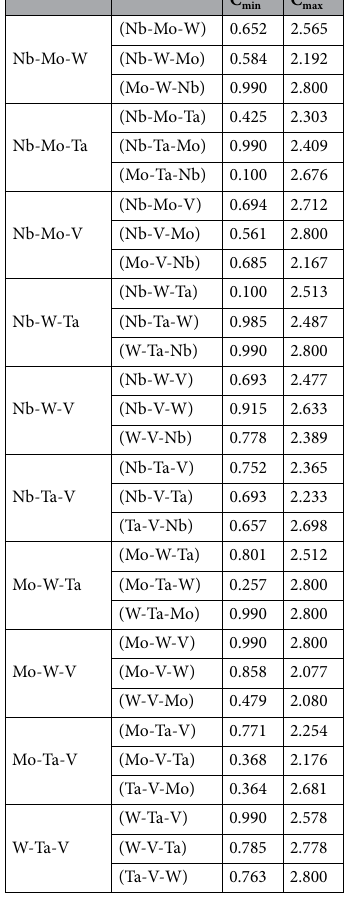
Table 3. The parameter sets of C min and C max for ternary elements in the LAMMPS format.